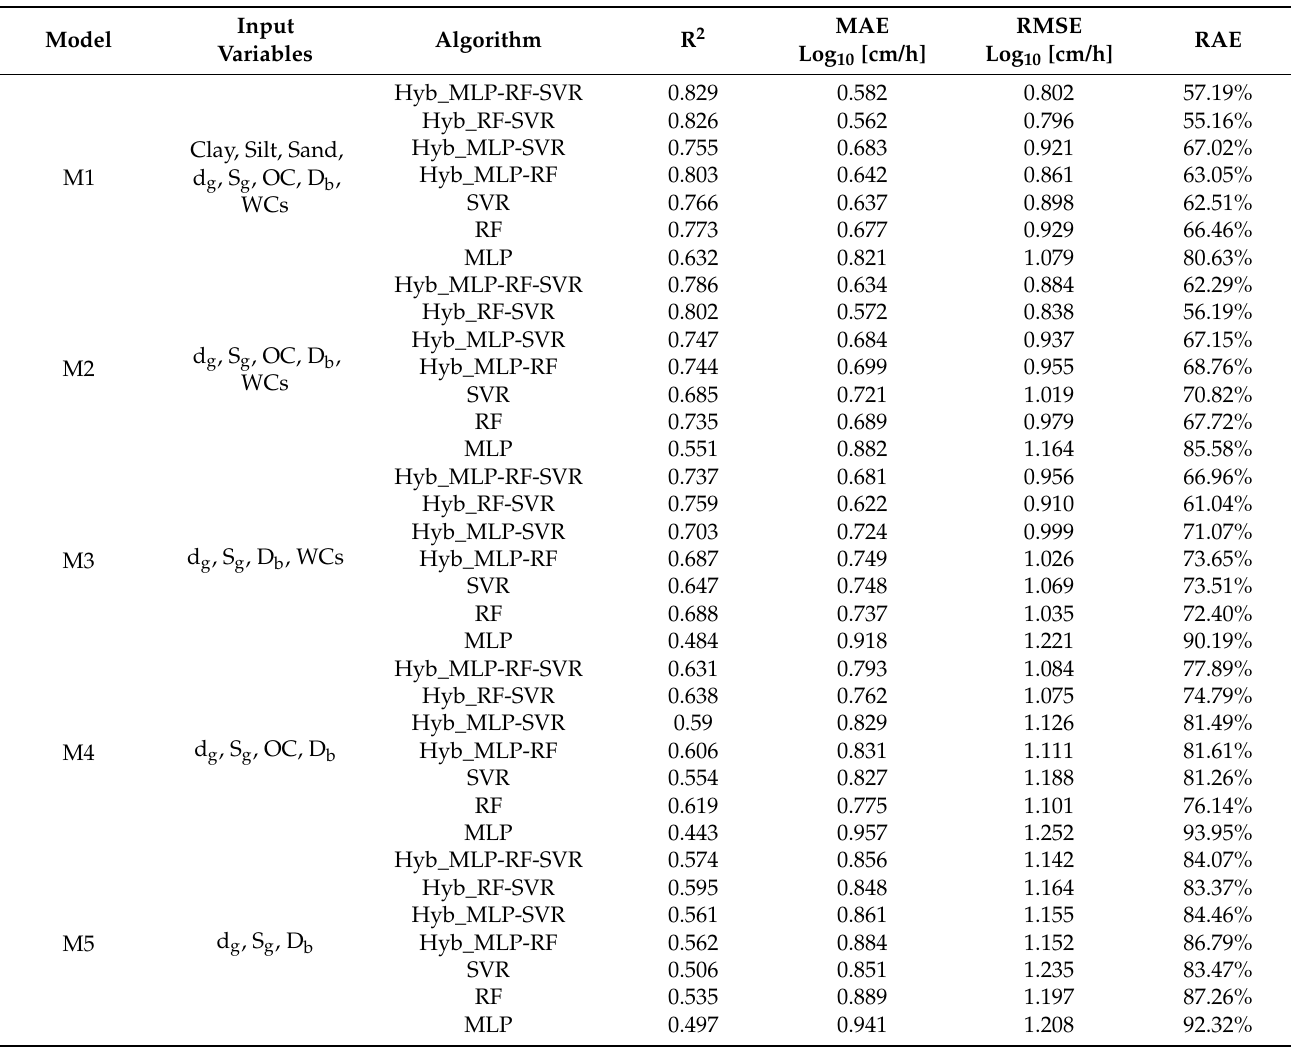
Table 3. Summary of the